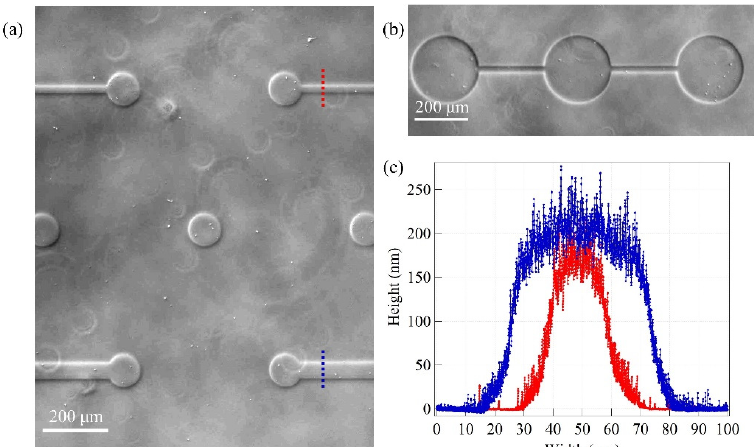
Figure 8. ( a , b ) Phase contrast images of ns-ZrO x patterns obtained with PRL silicon stencil masks. In ( a ) the diameter of the dots is 100 μ m, in ( b ) 250 μ m (referring to Supplementary Table S1, the labels of the masks are respectively Q16 and Q19). Alternating rows of dots are connected by 20 and 50 µ m wide bridges. ( c ) Atomic force microscopy (AFM) height profile maps of ns-ZrO x micrometric bridges. The blue and red traces correspond to 50 and 20 µ m wide bridges, respectively. The profiles were measured on different portions of the same sample: the thickness difference clearly visible in the two profiles can be attributed to the more effective blurring on the smaller mask openings.